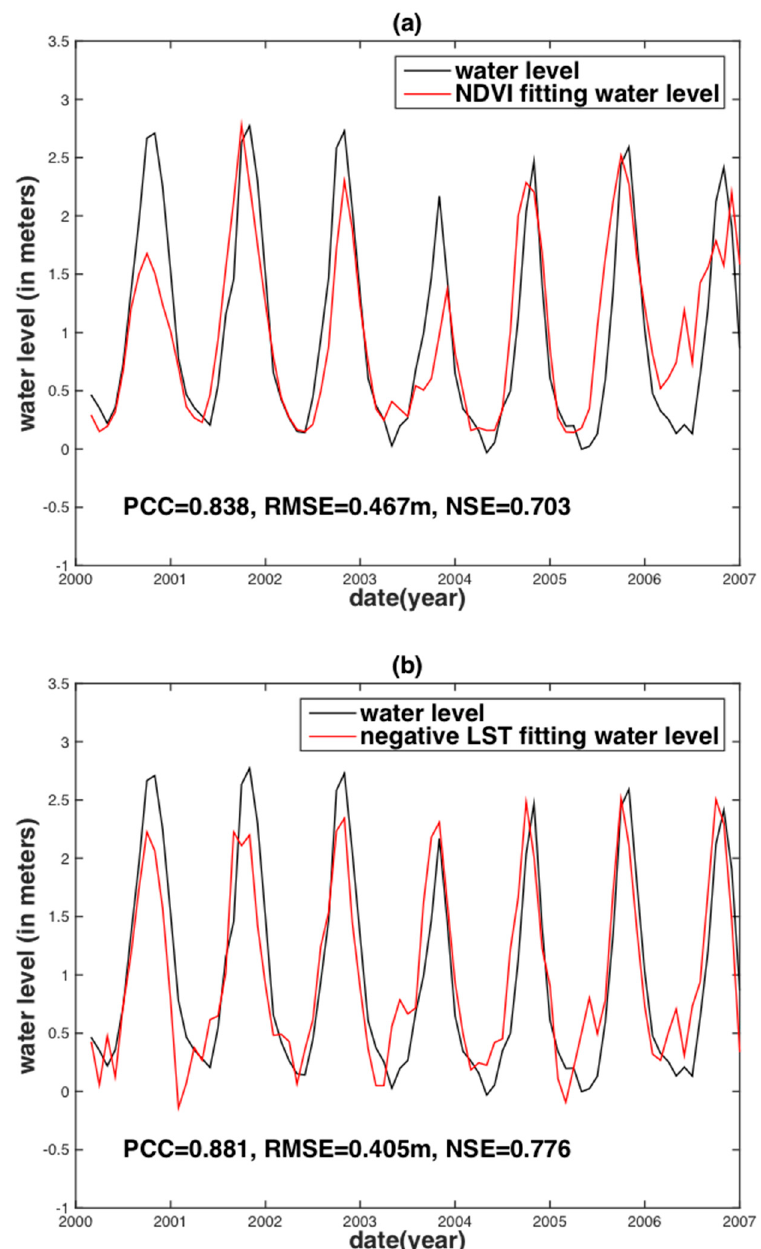
Figure 6. Water level reconstruction at the Vam Kenh station based on NDVI ( a ) and negative LST ( b ).